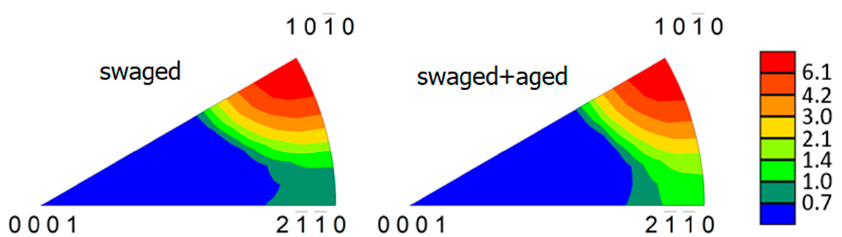
Figure 9. KAM distributions of the swaged and swaged + aged samples. Figure 10. IPFs of the swaged and aged samples calculated from the EBSD data. The extrusion direction is perpendicular to the